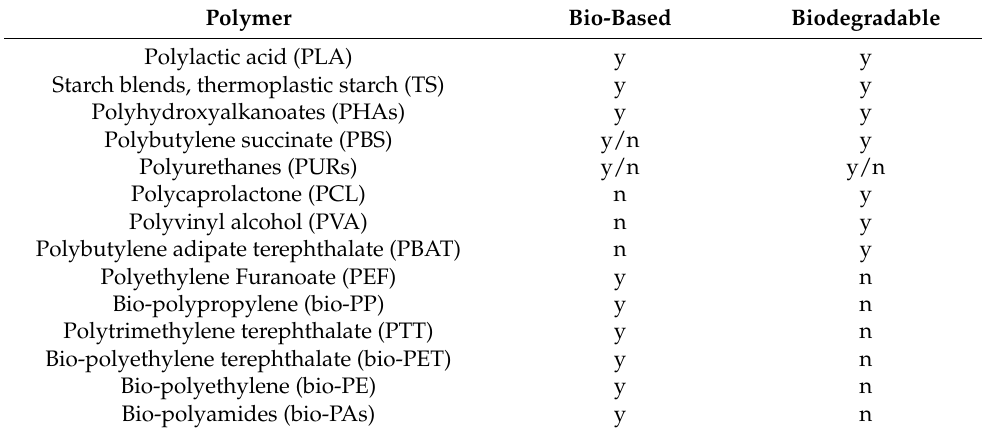
Table 1. Lists of bioplastics and indication of bio-based origin and biodegradability. In the table, “y” means yes, “n” means no, and “y/n” refers to both statements being